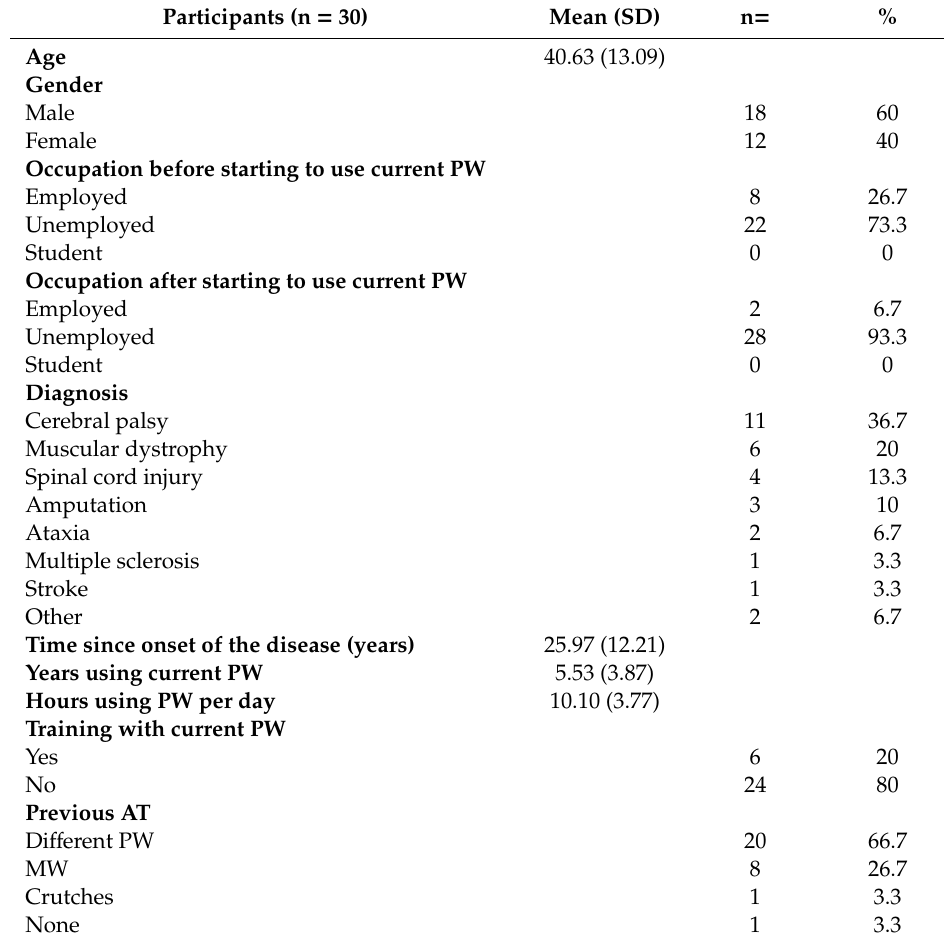
Table 1. Sample characterization.